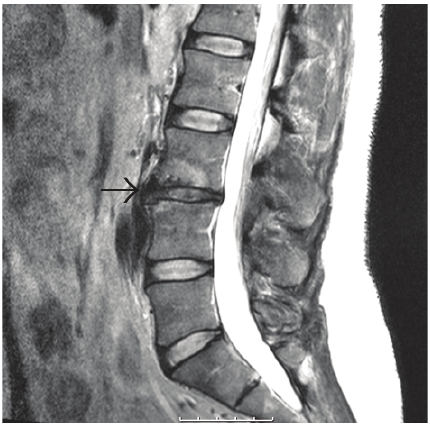
Figure 1: Disc space narrowing and degenerative changes at the L3- L4 level (arrow) on sagittal T2-weighted MRI.